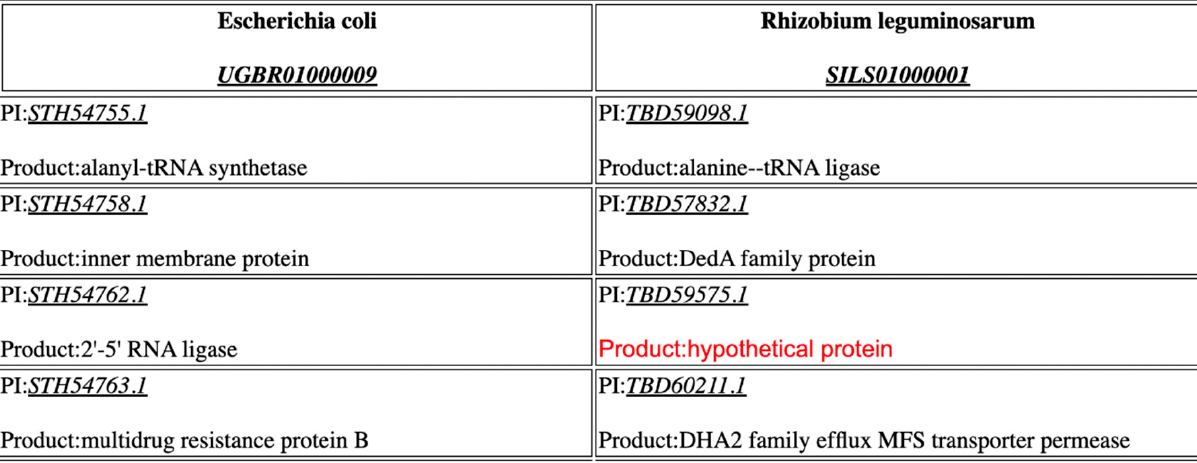
Figure 4. CoreGenes assists in the identification and annotation of hypothetical proteins. Here, the annotated hypothetical protein in Rhizobium leguminosarum , labeled in red, is putatively identified as 2’-5’ RNA ligase in a reference genome, E. coli . Flagging this to the user allows for a subsequent evaluation for